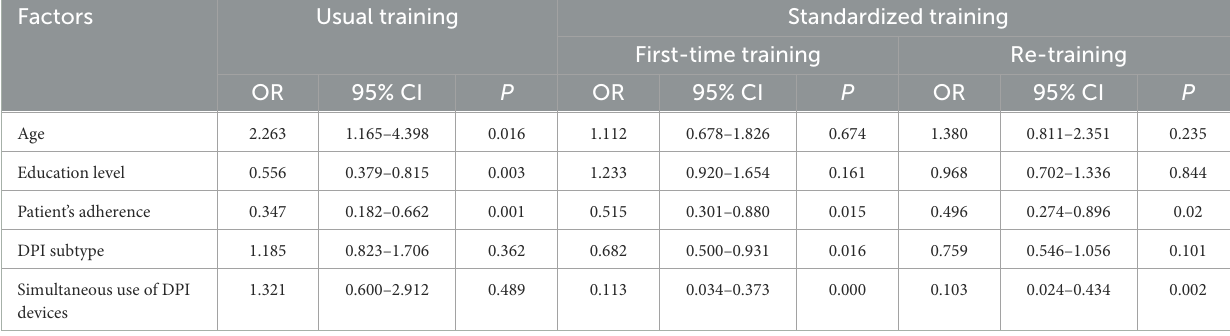
TABLE 5 Logistic regression analysis of key factors influencing the ability to use inhalers for the two models. Factors Usual training